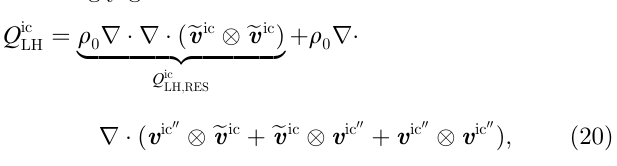
LES and from measurements at positions K 3, K 4 and K